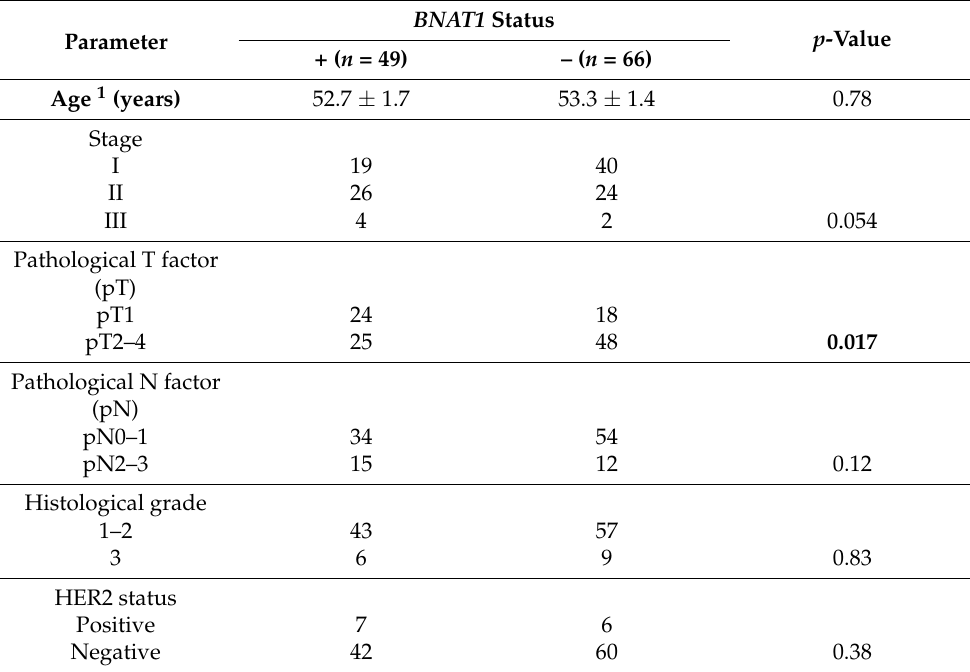
Table 3. Association between BNAT1 status and clinicopathological factors in 115 ER-positive breast carcinomas.